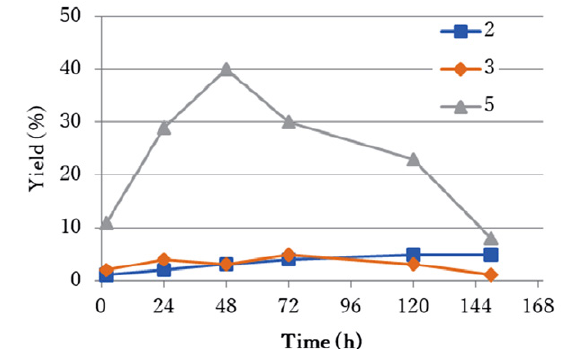
Figure 5. Evaluation of products 2 , 3 and 5 formed in the presence of commercial silica Si com.